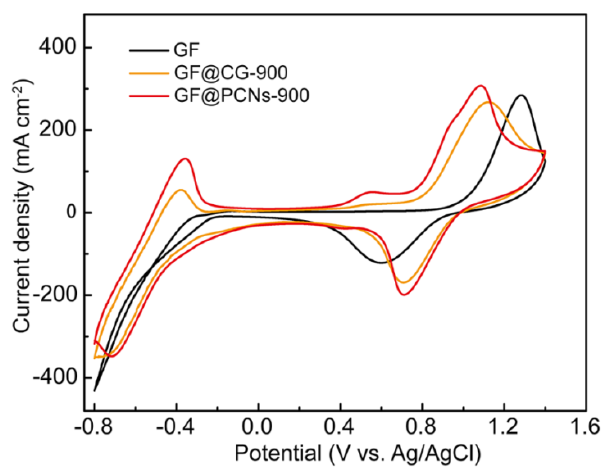
Figure 7. CV curves of GF, GF@CG-900 and GF@PCNs-900 at a scan rate of 10 mV s − 1 . The ion diffusion ability in the electrodes was analyzed by multi-sweep CV curves. Figure 8a–c displayed the CV curves of GF, GF@CG-900, and GF@PCNs-900 electrodes at scan rate of 5, 8, 10, 12, and 15 mV s − 1 , respectively. The relationship curve between the square root of the scan rate and peak current density is shown in Figure 8c, and their good reaction of the VO 2+ /VO 2+ couple. Based on Randles-Sevcik formula [55], it is known